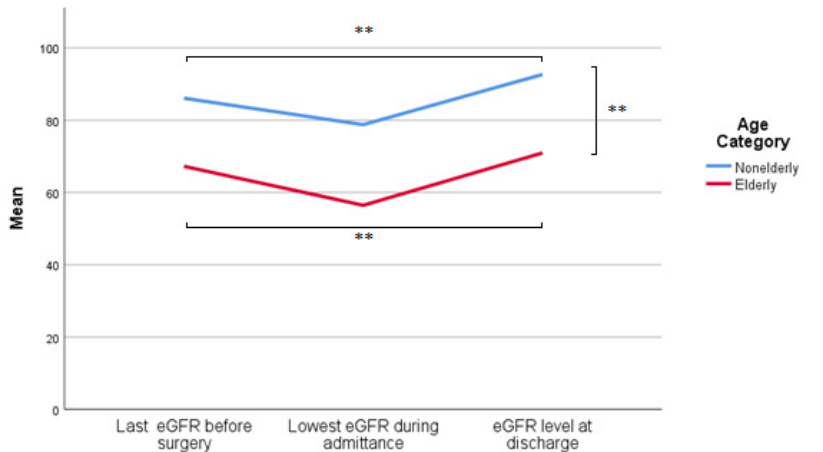
Figure 1. The Course of eGFR Level from Admission to Discharge. ** Significant at the p < 0.001 level.